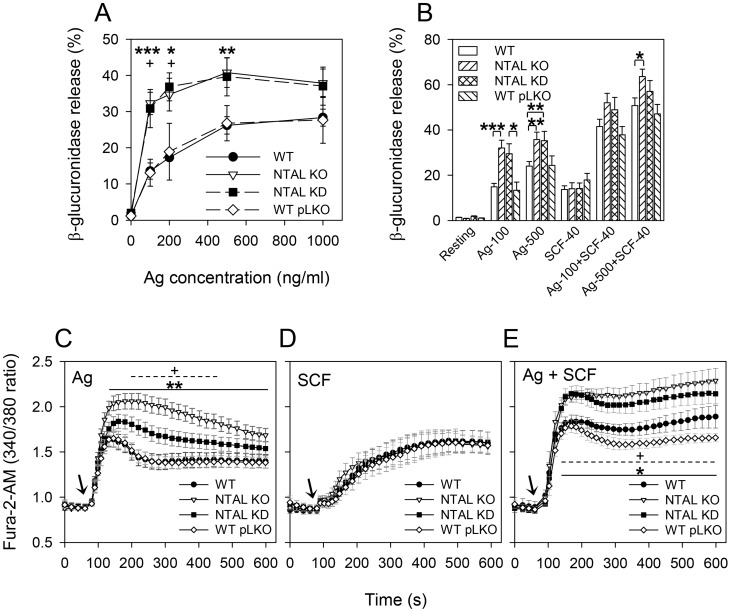
BMMCs with NTAL KD exhibit increased degranulation and calcium response.(A) IgE-sensitized BMMCs (WT, NTAL KO, NTAL KD, and WT pLKO) were stimulated for 30 minutes with various concentrations of Ag (TNP-BSA), and β-glucuronidase released into supernatant was determined as described in Materials and Methods. Data represent means ± SE from 7–17 independent experiments performed in duplicates or triplicates). (B) IgE-sensitized BMMCs were stimulated with Ag [TNP-BSA at a concentration 100 ng/ml (Ag-100) or 500 ng/ml (Ag-500)], SCF (40 ng/ml), or both activators together. Data represent means ± SE from 6–20 independent experiments). (C–E) BMMCs were sensitized with IgE, loaded with Fura-2-AM (1 µg/ml), then stimulated with Ag (100 ng/ml TNP-BSA; C), SCF (40 ng/ml; D) or both activators together (E) and free intracellular Ca2+ was monitored by measuring fluorescence emission at 510 nm after excitation at 340 and 380 nm. Arrows indicate addition of Ag and/or SCF. Data are means ± SE from 11 (C), 7 (D) or 6 (E) independent experiments performed in duplicates. All data presented in A–E were obtained with BMMCs isolated from 3–5 mice. *,+
p<0.05; **p<0.01; ***p<0.001; in A, C and E, significant differences between NTAL KOs and WTs (asterisks) and NTAL KDs and WT pLKOs (crosslets) are shown.